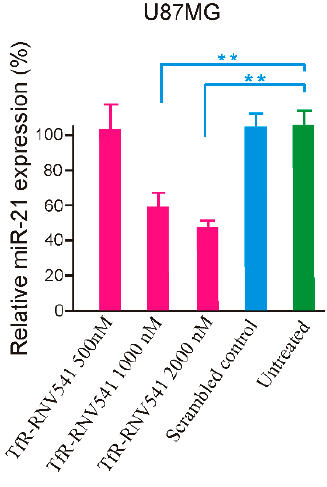
Figure 5. Evaluation of miR-21 inhibition using TfR aptamer-RNV541 antimiRzyme chimera in U87MGglioblastoma cells. Cells were treated with TfR aptamer-RNV541 chimera at the indicated concentrations for 24 h in the absence of transfection reagents. The total miRNAs were then isolated and the quantification of miR-21 expression was conducted via RT-qPCR. ** p < 0.01.